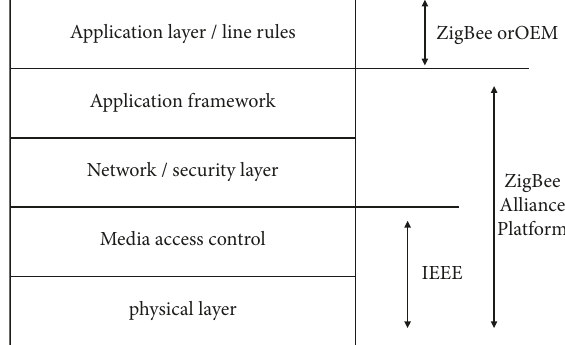
Figure 3: ZigBee protocol stack structure.